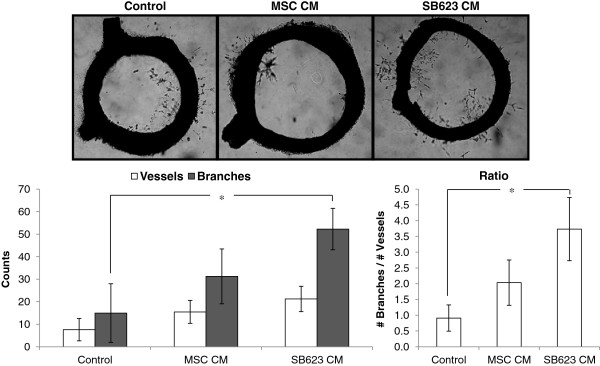
Branching of new vessels is enhanced by MSC- and SB623 cell-secreted factors. Following suppression of endogenous outgrowth, rat aortic rings were plated in gels with either OptiMEM (“Control”) or OptiMEM conditioned by MSCs or SB623 cells. After 7–10 days, there were more vessels with conditioned medium and significantly more branching points in SB623 CM versus OptiMEM only (*p < 0.05). Representative images of aortic rings after 7 days in culture with OptiMEM only, or MSC-conditoned medium, or SB623-conditioned medium. Mean ± SEM.